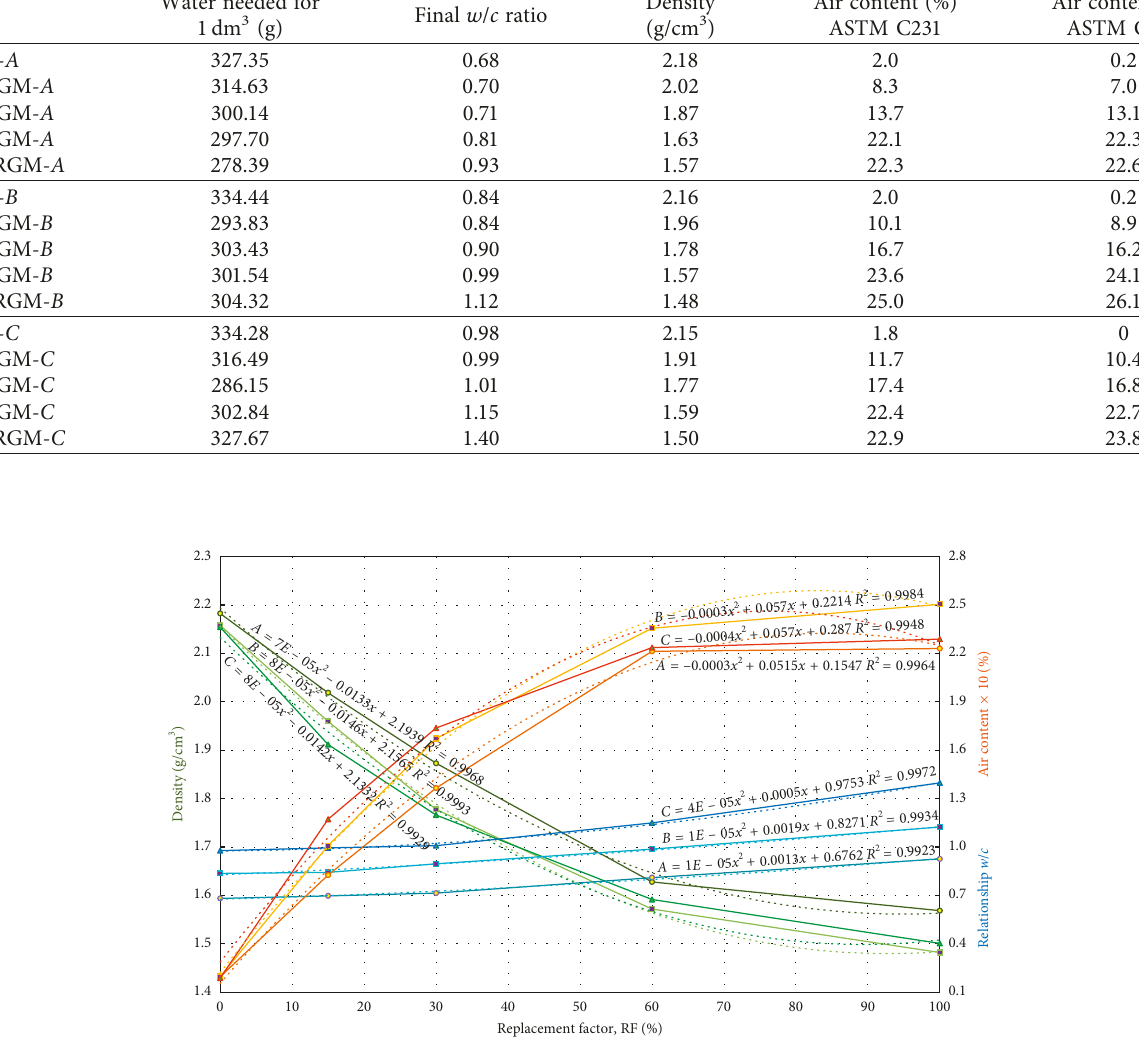
Figure 2: Experimental values of the UM and RGM, and regression equations with their resulting reliability.